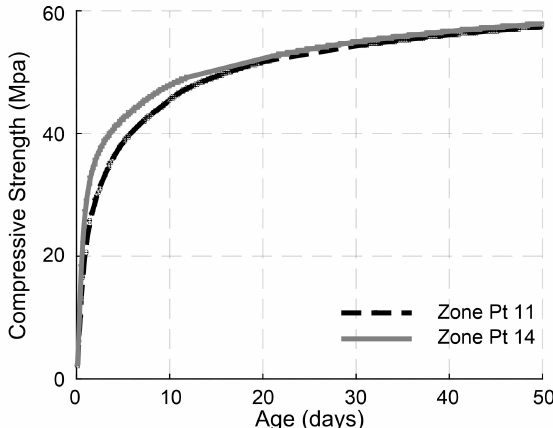
Figure 12. Modelling of concrete compressive strength evolution in beam 1.